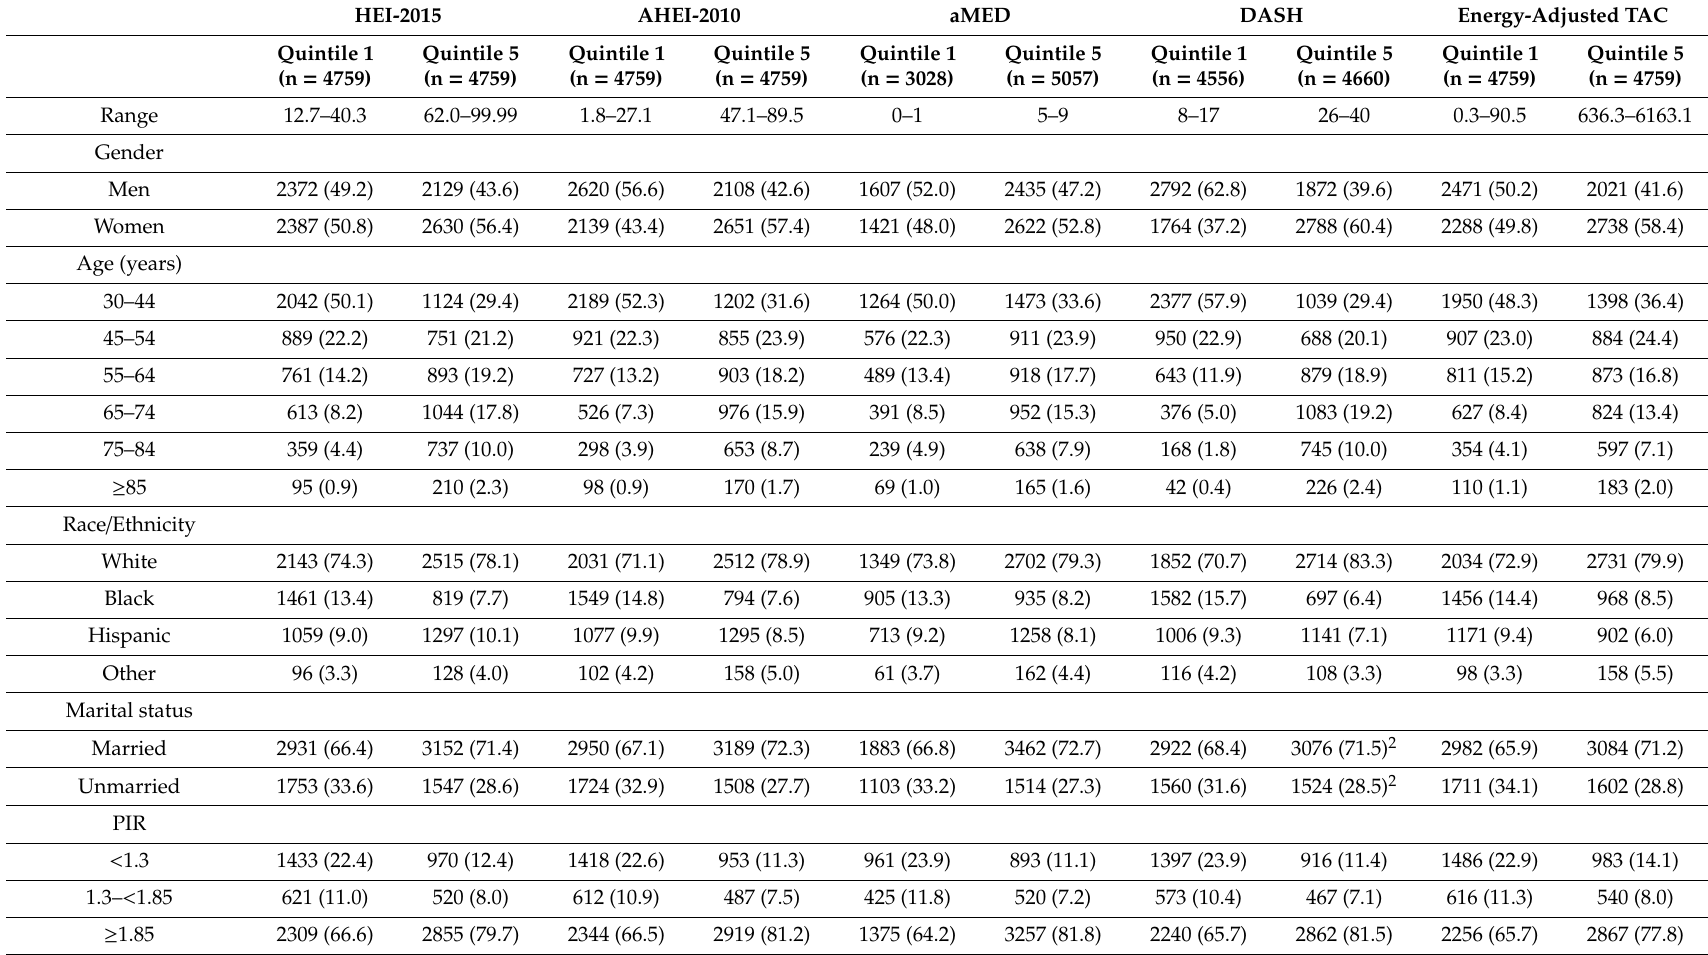
Table 1. Baseline characteristics of study participants according to quintiles of diet quality index scores and dietary total antioxidant capacity (mg VCE / day) 1